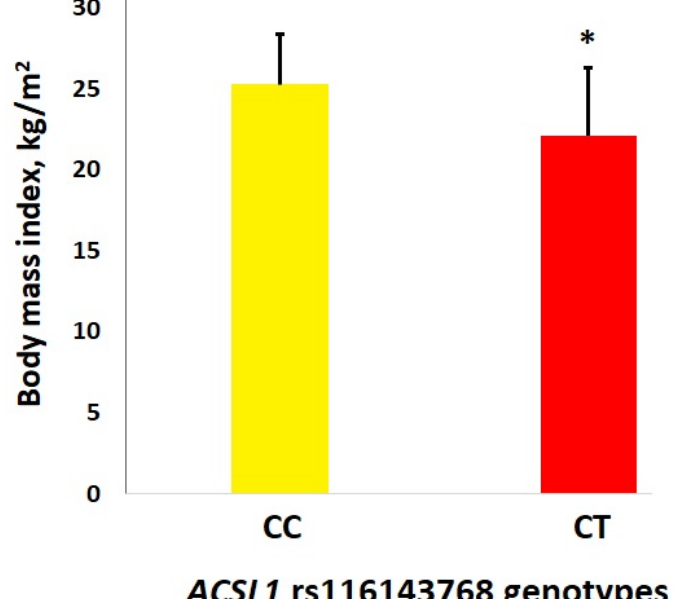
Table 2. Summary statistics of the top SNPs associated with changes in body composition.